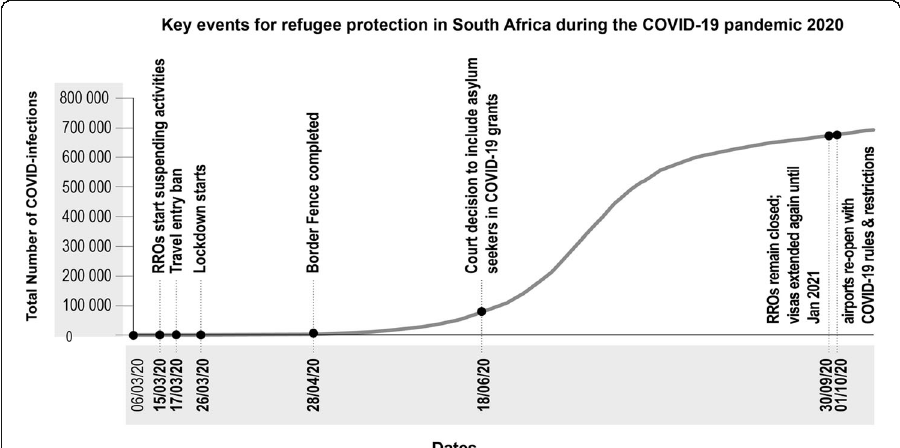
Fig. 1 Key events for refugee protection in South Africa during the COVID-19 pandemic 2020. Source for COVID-19 infections: (Roser et al.,